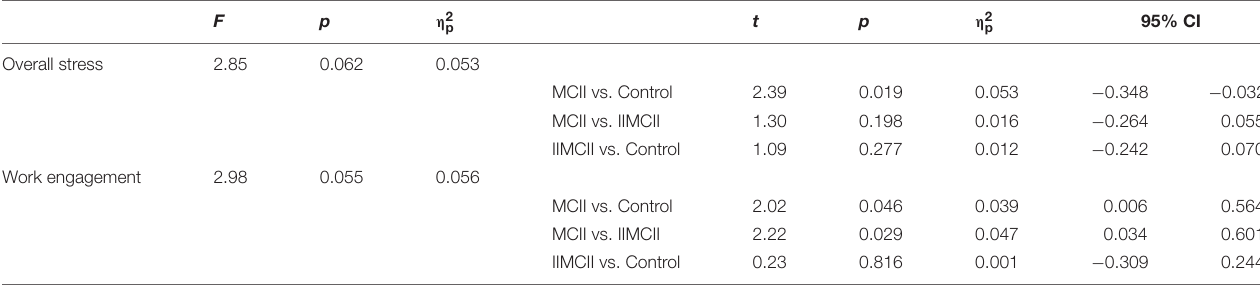
TABLE 2 | Comparing the three conditions regarding overall stress and work engagement. F p η 2 p t p η 2 p 95% CI Overall stress 2.85 0.062 0.053 MCII vs.